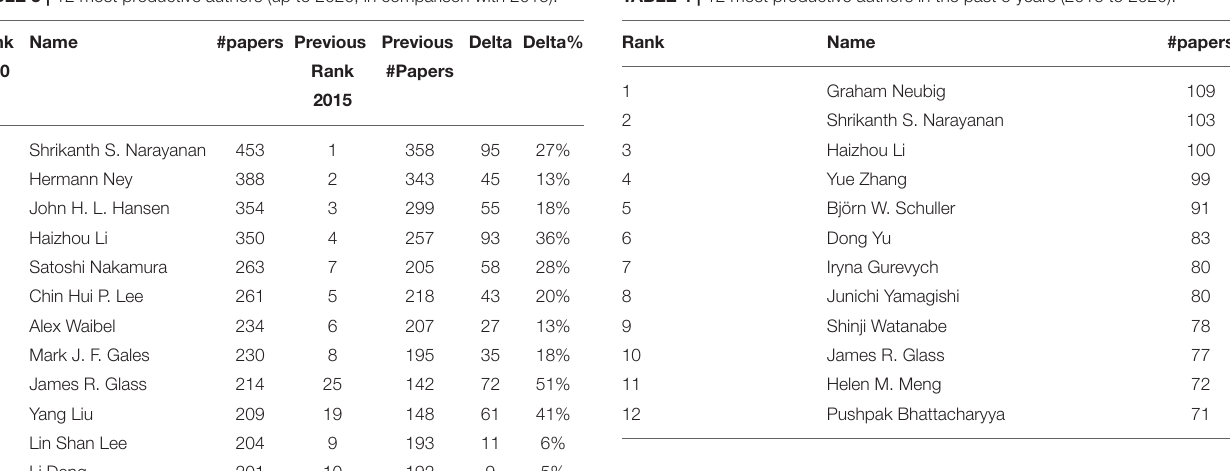
FIGURE 12 | Percentage of female authors across the sources in 2020 (red) and difference with 2015 (blue). TABLE 3 | 12 most productive authors (up to 2020, in comparison with 2015). TABLE 4 | 12 most productive authors in the past 5 years (2016 to